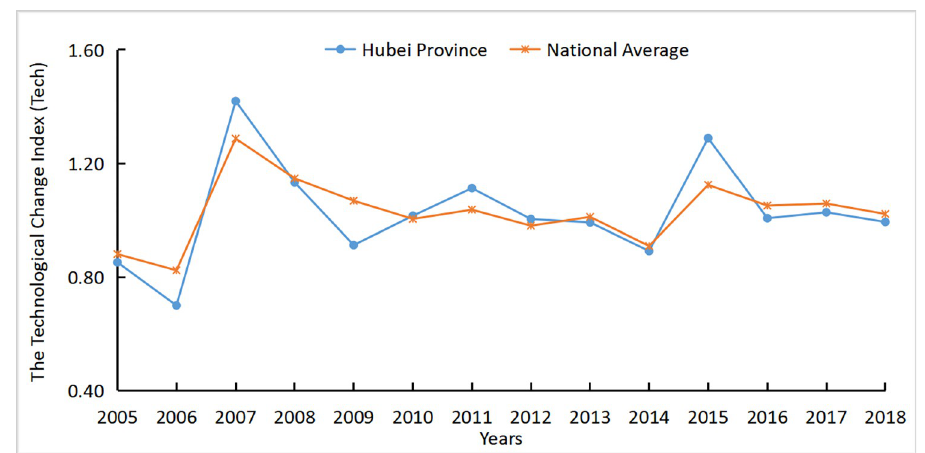
Fig 7. Tech index of Hubei Province and national average from 2004 to